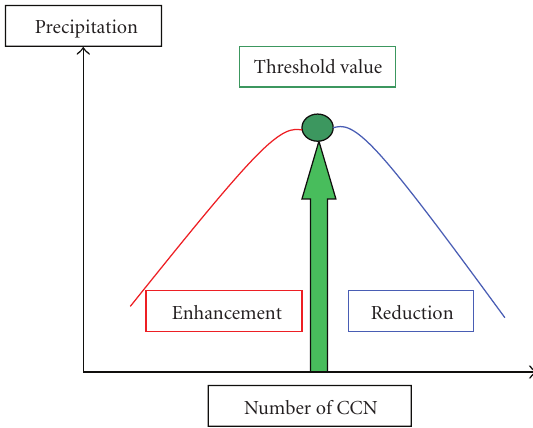
Figure 1: Schematic picture for the e ff ect of changes in cloud nuclei (CCN) on precipitation. The red regime represents for the enhancement of precipitation with increase of CCN, and the blue regime represents for the reduction of precipitation with increase of CCN. The green dot indicates the threshold for the enhancement/reduction transition point.